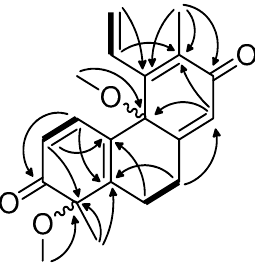
Figure 2. Diagnostic COSY ( ▬ ) and HMBC (H → C) correlations of compounds 1a and 1b . ) and HMBC (H → C) correlations of compounds 1a and 1b . All of the above evidence confirmed the 2D structures of compounds 1a and 1b